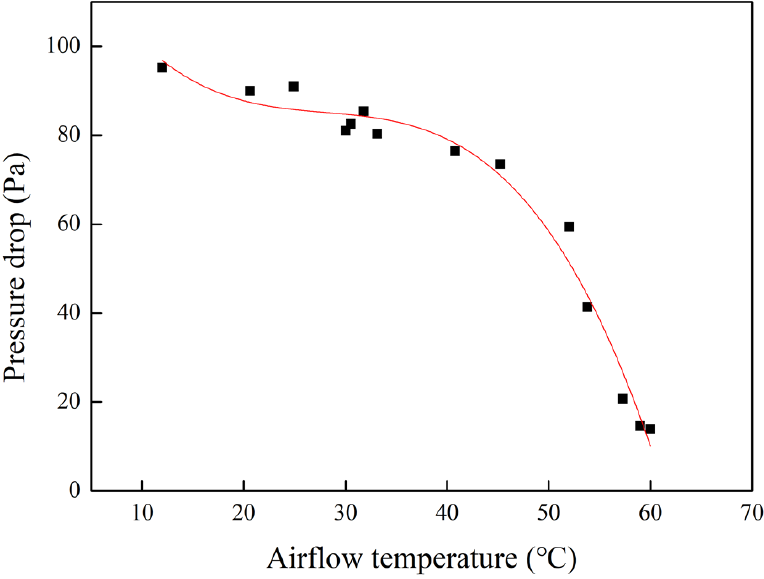
Figure 8. Pressure drop as a function of airflow temperature ( v = 7.60 m/s and t = 8 s).